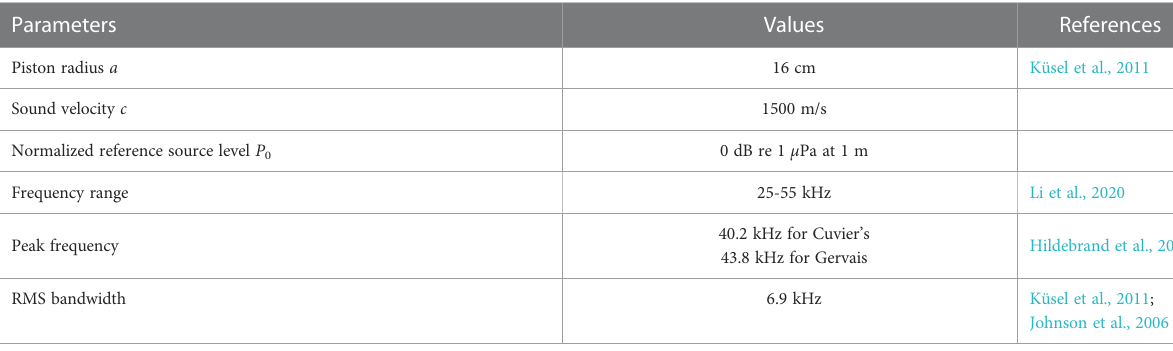
TABLE 2 Parameters for directivity model.